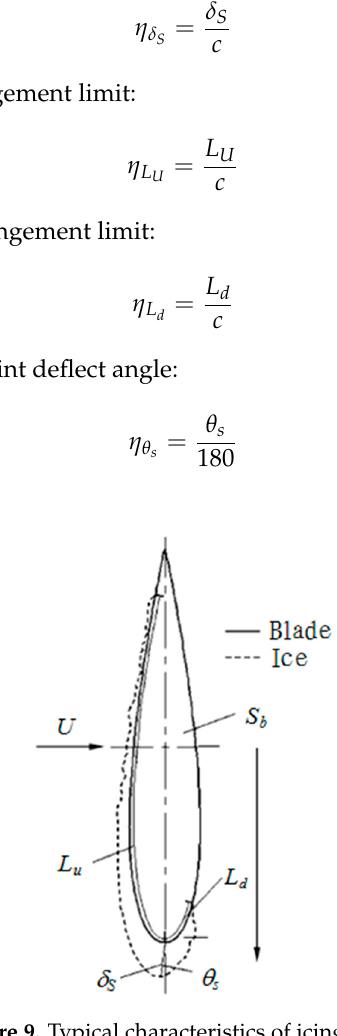
Figure 9. Typical characteristics of icing shape.